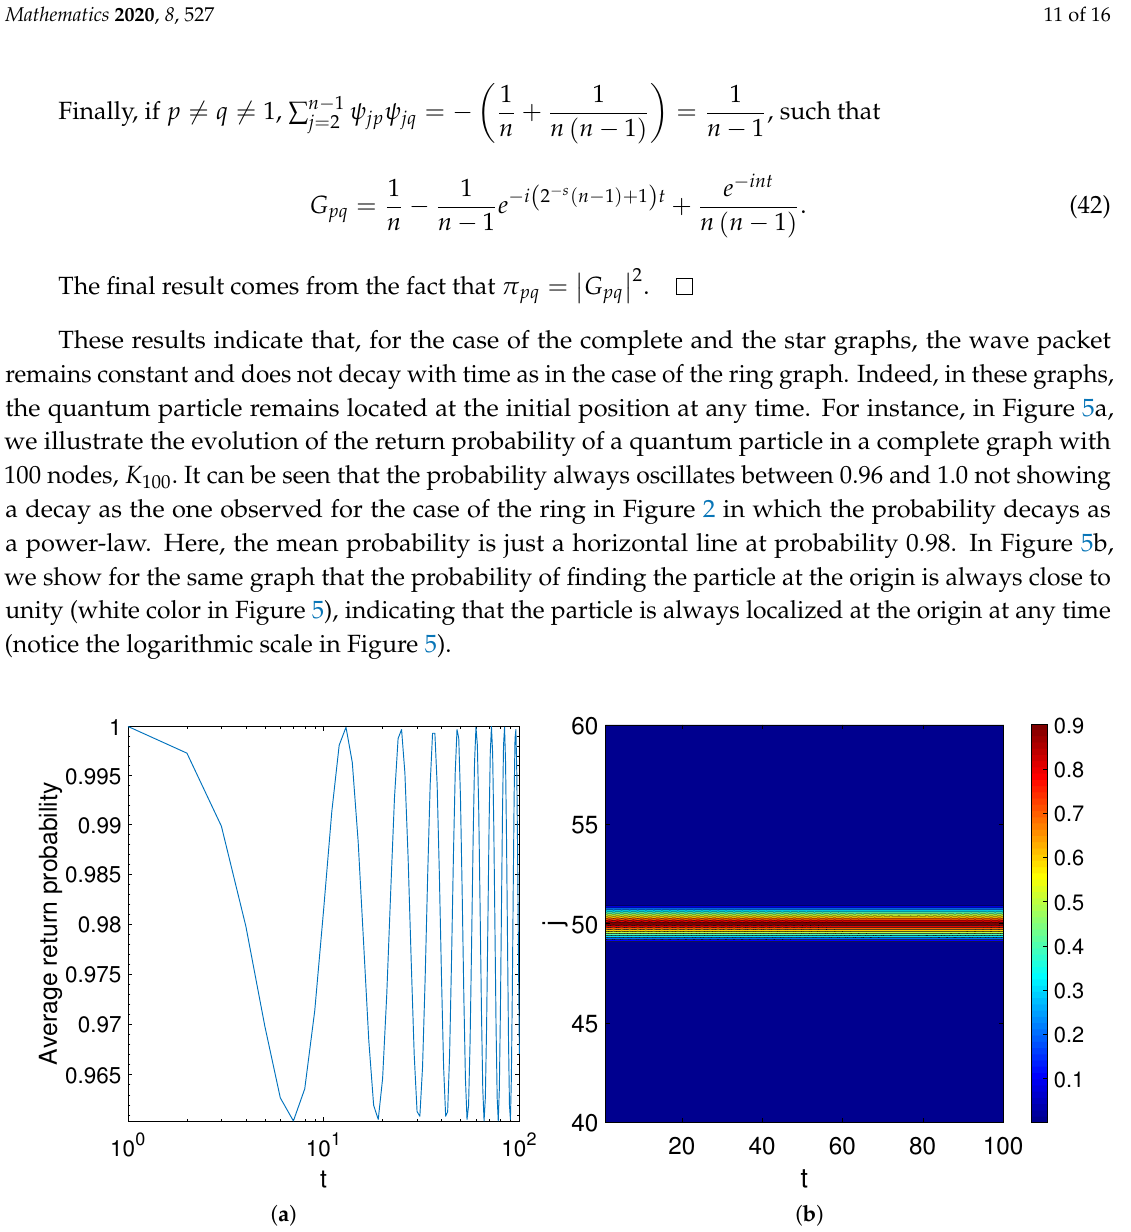
Figure 5. ( a ) plot of the average return probability versus time in a complete graph K 100 ; ( b ) transition probabilities between the node v = 50 and the rest of the nodes in the complete graph K 100 . Only the zoomed region between nodes 40 and 60 is shown for the sake of visibility. The colobar in ( b ) corresponds to the return